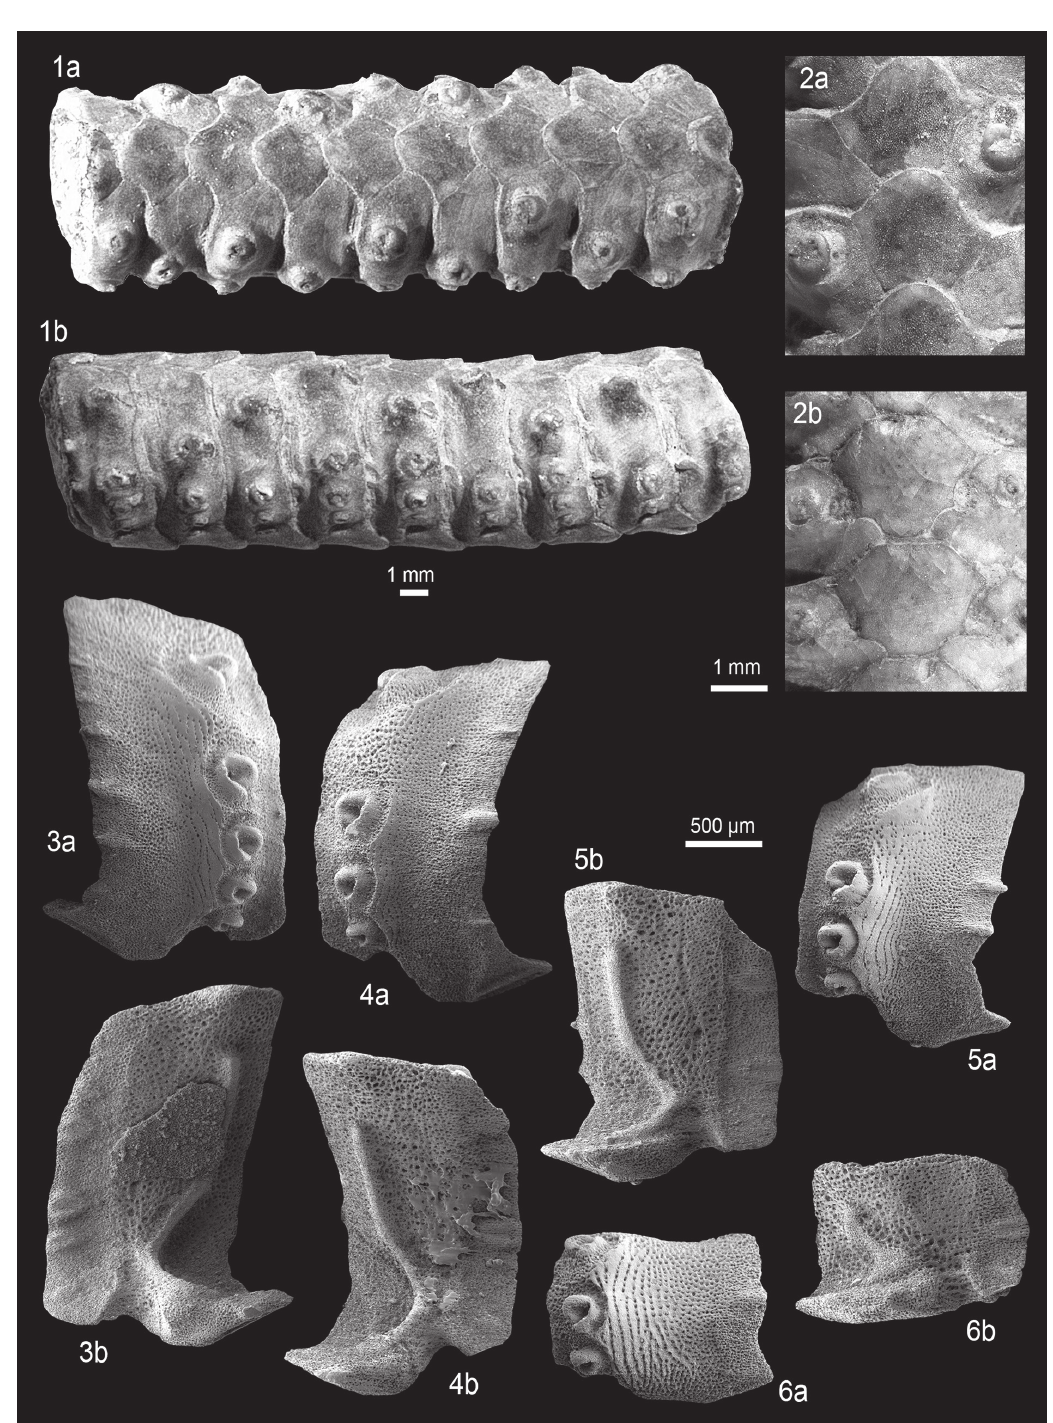
Fig. 24. Fossil lateral arm plates in external (a) and internal (b) views and articulated arm fragment of ophiacanthid brittle stars. 1-2. Alternacantha arges sp. nov. from the late Oxfordian (Late Jurassic) of Raedersdorf, France; M 610 in dorsal (1a) and ventral (1b) views and with details of dorsal (2a) and ventral (2b) arm plating. 3-6. Alternacantha dilionessa sp. nov. from the early Kimmeridgian of the Pointe du Chay, France. 3. GZG.INV.78662 (holotype), proximal LAP. 4. GZG.INV.78663 (paratype), proximal LAP. 5. GZG.INV.78664 (paratype), median LAP. 6. GZG.INV.78665 (paratype), distal LAP. One common scale bar for 1, for 2 and for 3-6,